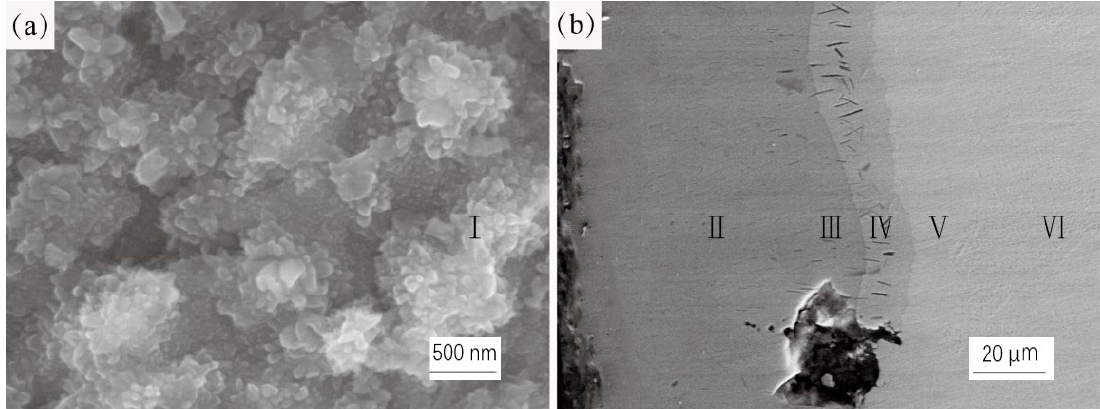
Figure 5. The test region of energy-dispersive spectrometry (EDS) under optimal technology ( a ) the surface of aluminide layer; ( b ) the cross-sectional of aluminide layer.